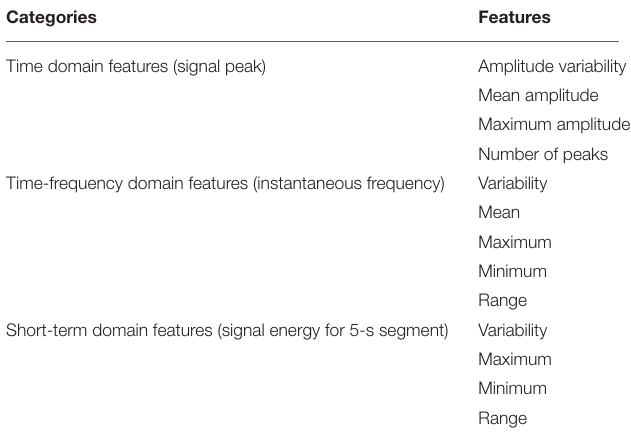
TABLE 1 | Statistical features.